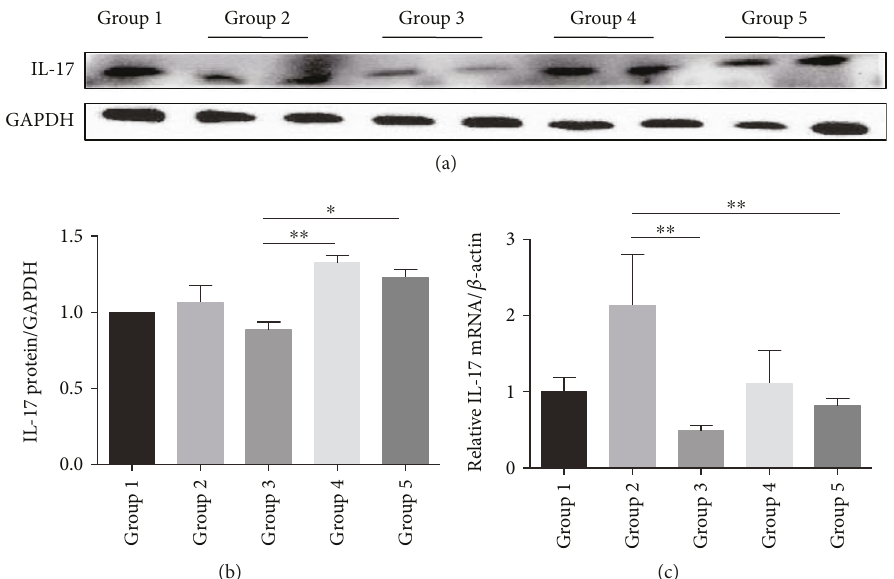
Figure 7: Bi fi co modulated the expression of IL-17. (a, b) Western blot analysis of IL-17 protein expression levels in colonic tissues. Group 1 normal ( n = 3 ); group 2 Bi fi co ( n = 6 ); group 3 colitis ( n = 6 ); group 4 pretreated- Bi fi co -colitis ( n = 6 ); group 5 pretreated +treated- Bi fi co - colitis ( n = 6 ). (c) The levels of IL-17 mRNA ( n = 8 – 11/group). Data are means ± SEM